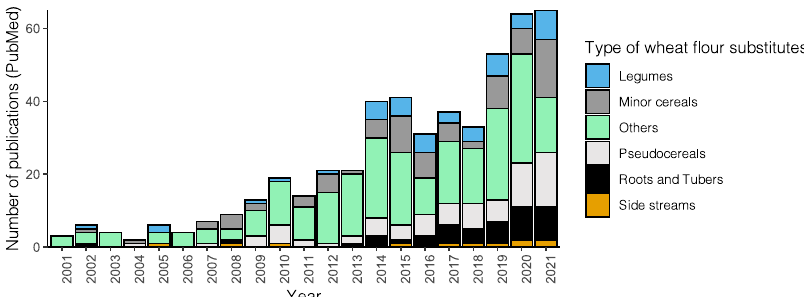
Fig. 1 Number of publications per year in the PubMed database related to composite bread over the past 20 years (2001 – 2021). The search was conducted using the following key words: (bread [Title/Abstract]) AND (( “ composite fl our ” ) OR ( “ non-wheat ” ) OR ((legum*) AND ( fl our)) OR ((pulse*) AND ( fl our)) OR ((root*) AND ( fl our)) OR ((tuber*) AND ( fl our))OR ((barley) AND ( fl our)) OR ((sorghum) AND ( fl our)) OR ((amaranth) AND ( fl our)) OR ((quinoa) AND ( fl our)) OR ((BSG) AND ( fl our)) OR ((buckwheat) AND ( fl our)) OR ((oat) AND ( fl our)) OR ((millet) AND ( fl our)) OR ((oilseed) AND ( fl our)) OR ((cassava) AND ( fl our)) OR ((yam) AND ( fl our)) OR ((potato) AND ( fl our)) OR ((side stream) AND ( fl